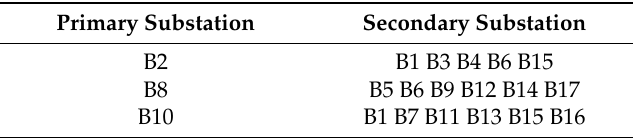
Table 2. Results after the uniform distribution of secondary